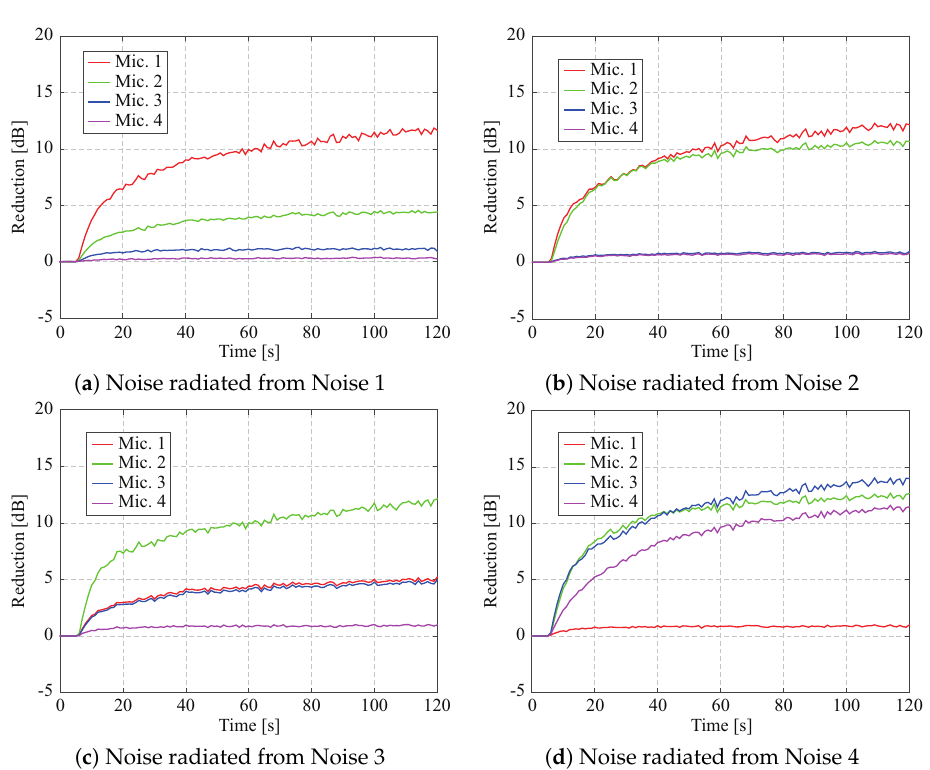
Figure 10. Noise reduction performance of a single-channel feedforward ANC system in the